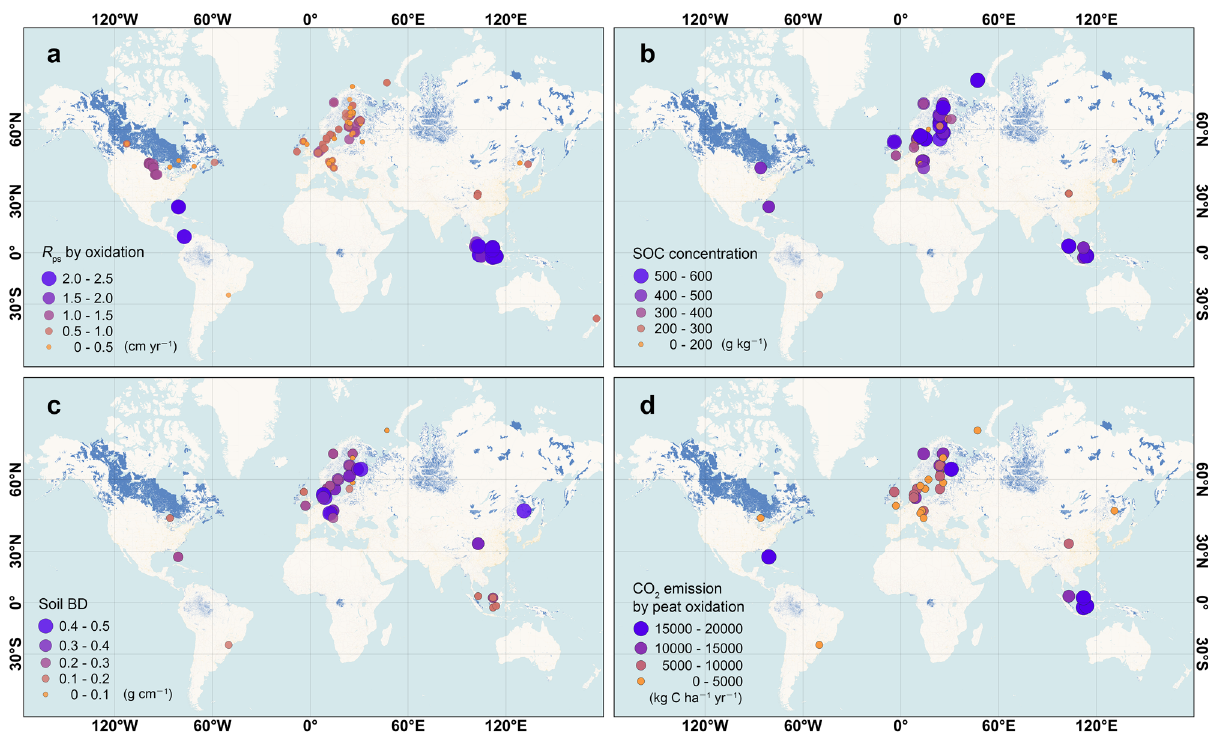
Fig. 6 Peat subsidence rate ( R ps ) (cm yr – 1 ) due to oxidation and associated soil heterotrophic CO 2 emissions. Spatial variations in the a estimated R ps due to oxidation of drained peatlands, b soil organic carbon (SOC) concentration (g kg – 1 ) of pristine peatlands, c soil bulk density (BD, g cm – 3 ) of pristine peatlands, and d estimated soil heterotrophic CO 2 emissions due to peat oxidation (kg C ha – 1 yr – 1 ) among global drained peatlands. For the calculation processes of R ps and HR, see the Methods. The gray-blue regions indicate the global distributions of peatlands derived from PEATMAT 5 .